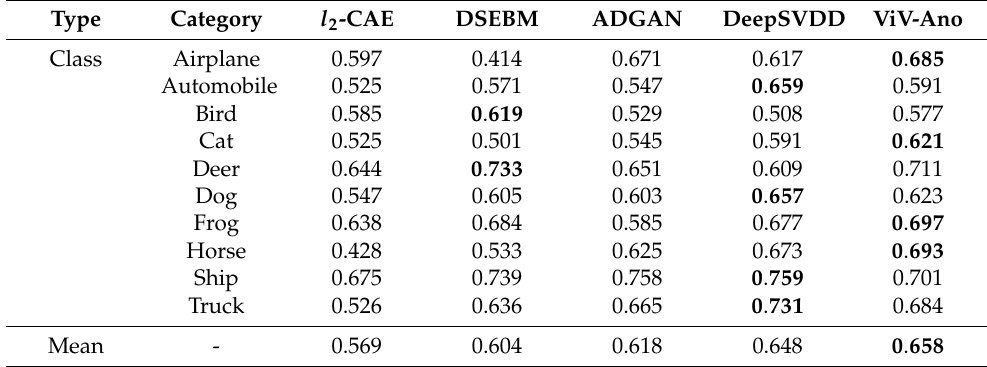
Table 2. Comparison of anomaly detection method performances on CIFAR10.